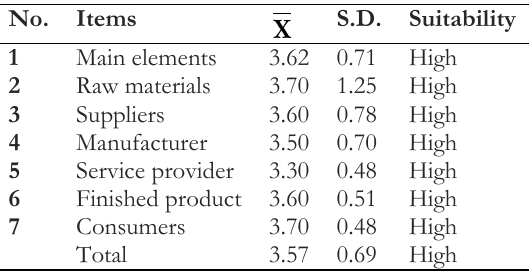
Table 2. The assessment of the suitability of information system model for educational management in supply chain for Thai higher education